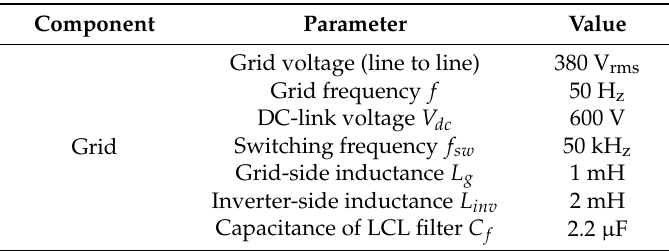
Table 1. Parameter specifications in the